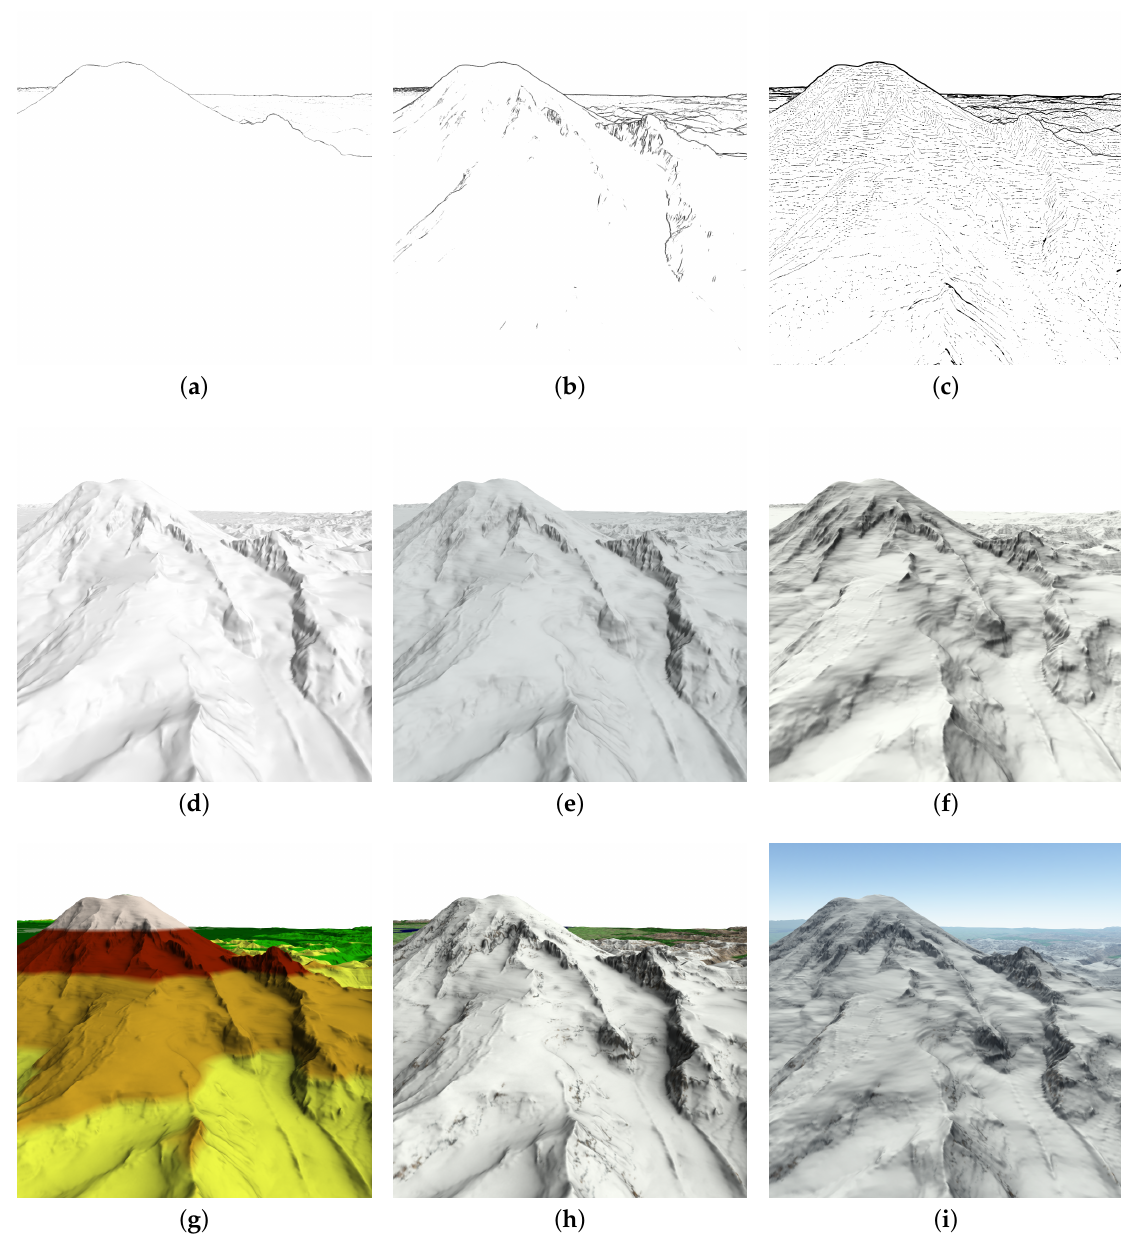
Figure 7. Parametrizing the terrain visualization. ( a – c ) Line drawings: ( a ) silhouettes; ( b ) enhanced edges derived from terrain curvature; ( c ) enhanced edges derived from depth variation. ( d – i ) Shading: ( d ) Phong illumination; ( e ) ambient occlusion; ( f ) ambient aperture lighting; ( g ) elevation-colored texture; ( h ) realistic surface texture; ( i ) atmospheric